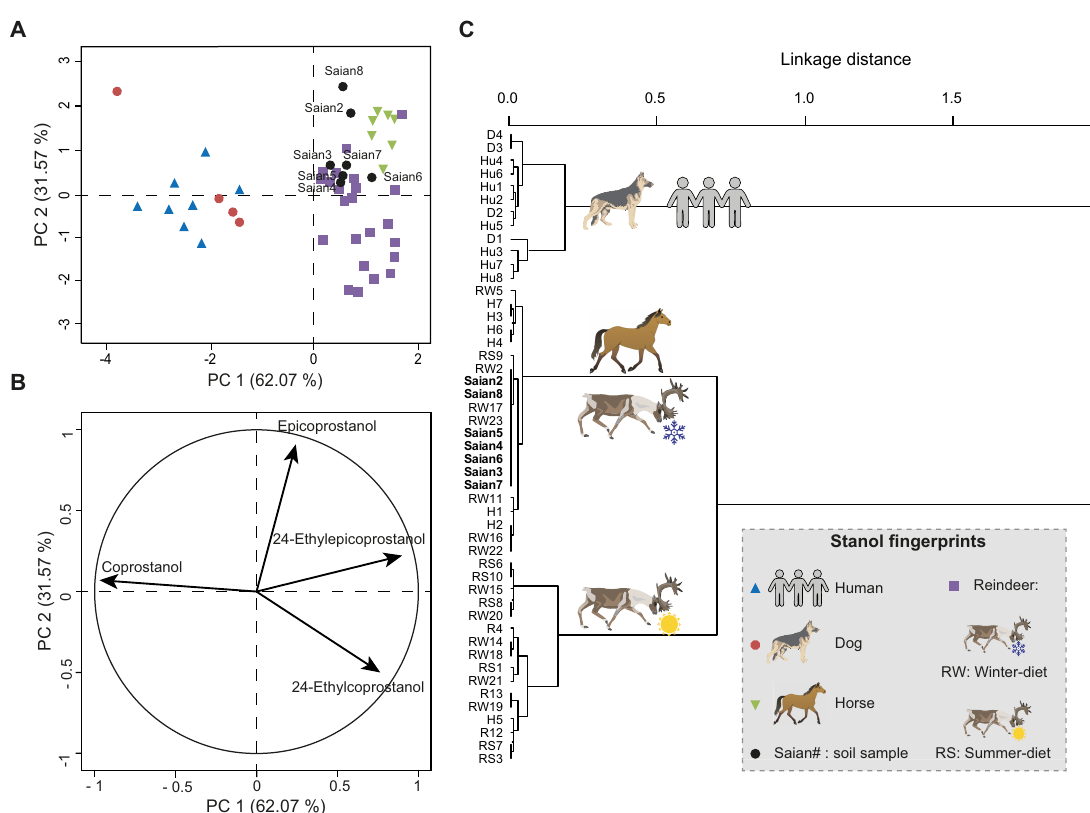
Fig 7. Multivariate analyses to identify the faecal fingerprints of soil samples from the Tofa site (Sai ͡ an Mountains) based on only the four compounds commonly used in the literature: coprostanol, epicoprostanol, 24-ethylcoprostanol and 24-ethylepicoprostanol. PCA and HCPC of the four main 5 β -stanols distribution (arcsine-root transformed) of reference faecal material from dog (D), horse (H), human (Hu) and reindeer (R) and soil samples (Saian). Reference and soil samples nomenclature can be found in S2 Table. ( A ) PCA score plot of PC1 and PC2. The high variance explained by the first two PCs is due to the low number of variables (four). ( B ) PCA correlation circle of PC1 and PC2. ( C ) Dendrogram obtained by HCPC from the first two PCs of the PCA.